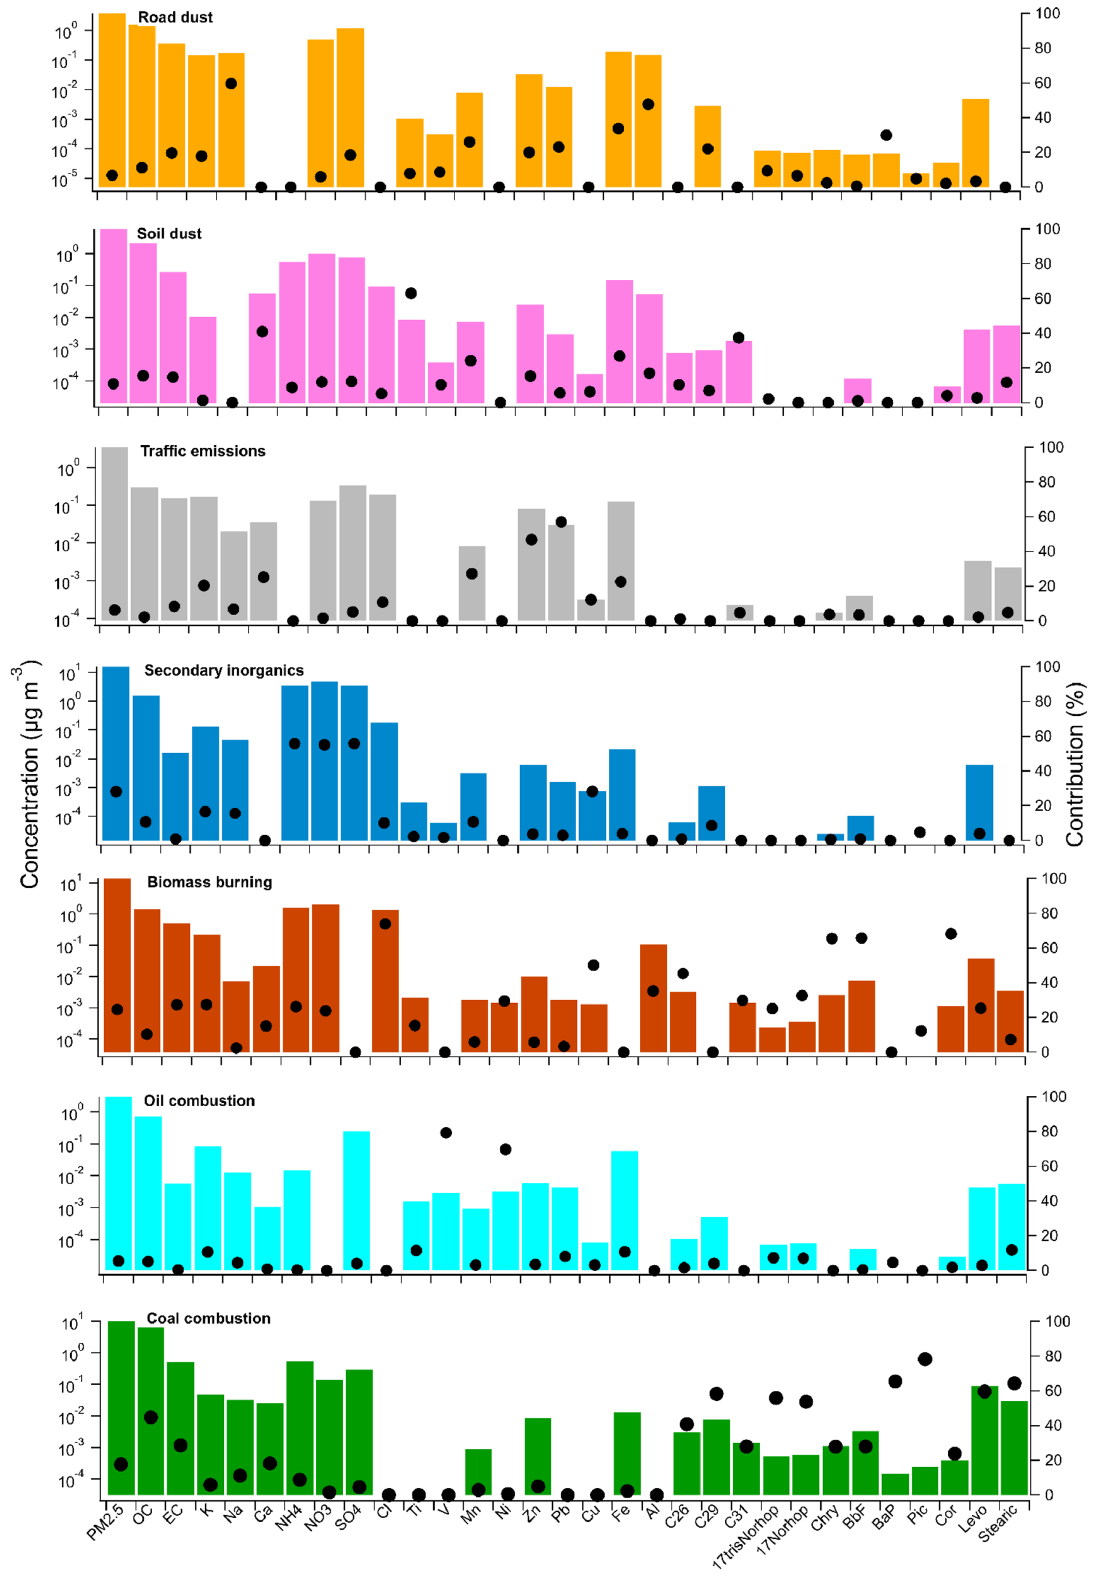
Figure 1. Chemical profiles for the identified factors at IAP and PG. The bars show the composition profile (left axis) and the dots the Explained Variation (right